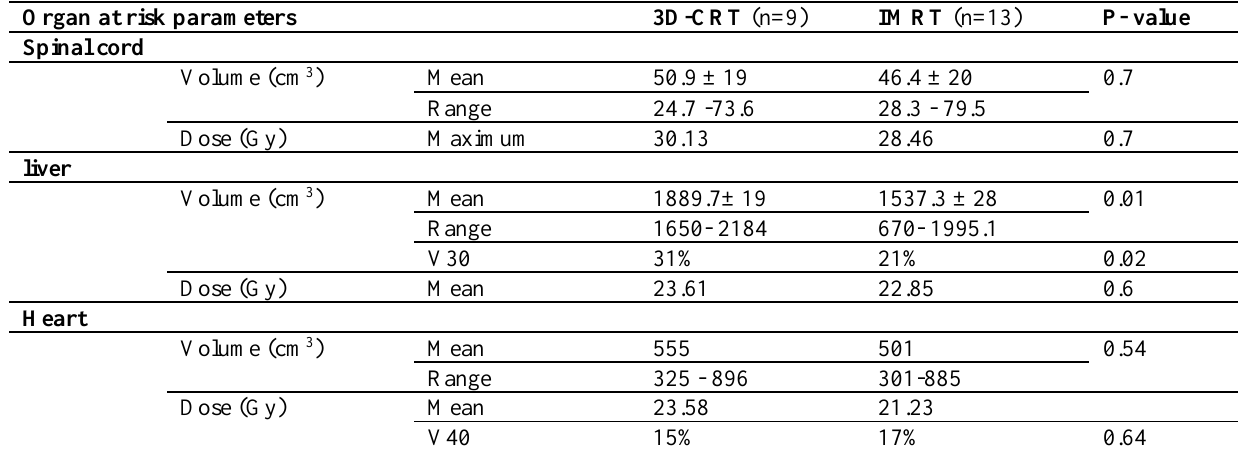
Table 3: DVH parameters of 3D-CRT and IMRT for the organs at risk Organ at risk